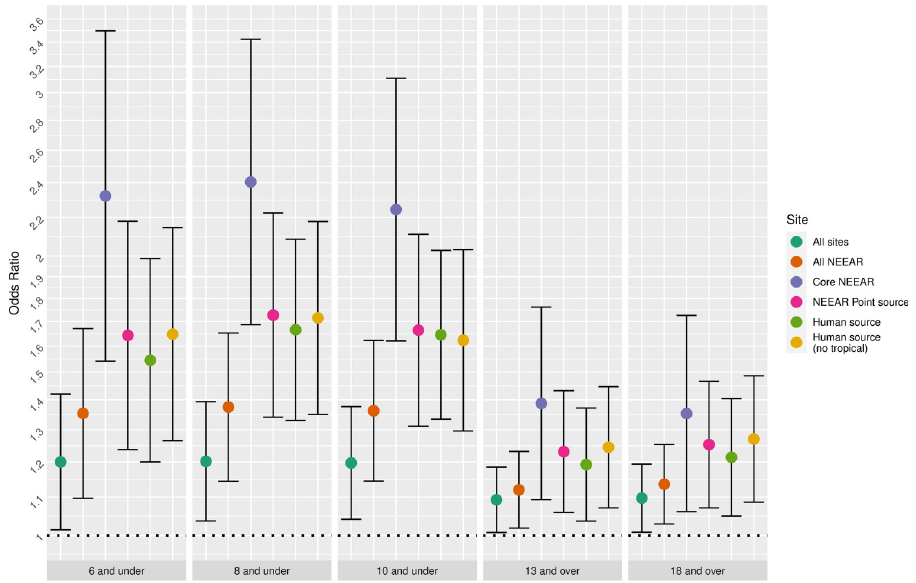
Fig 10. Odds ratios for diarrhea associated with and 1 log10 increase in Enterococcus qPCR CE among body immersion